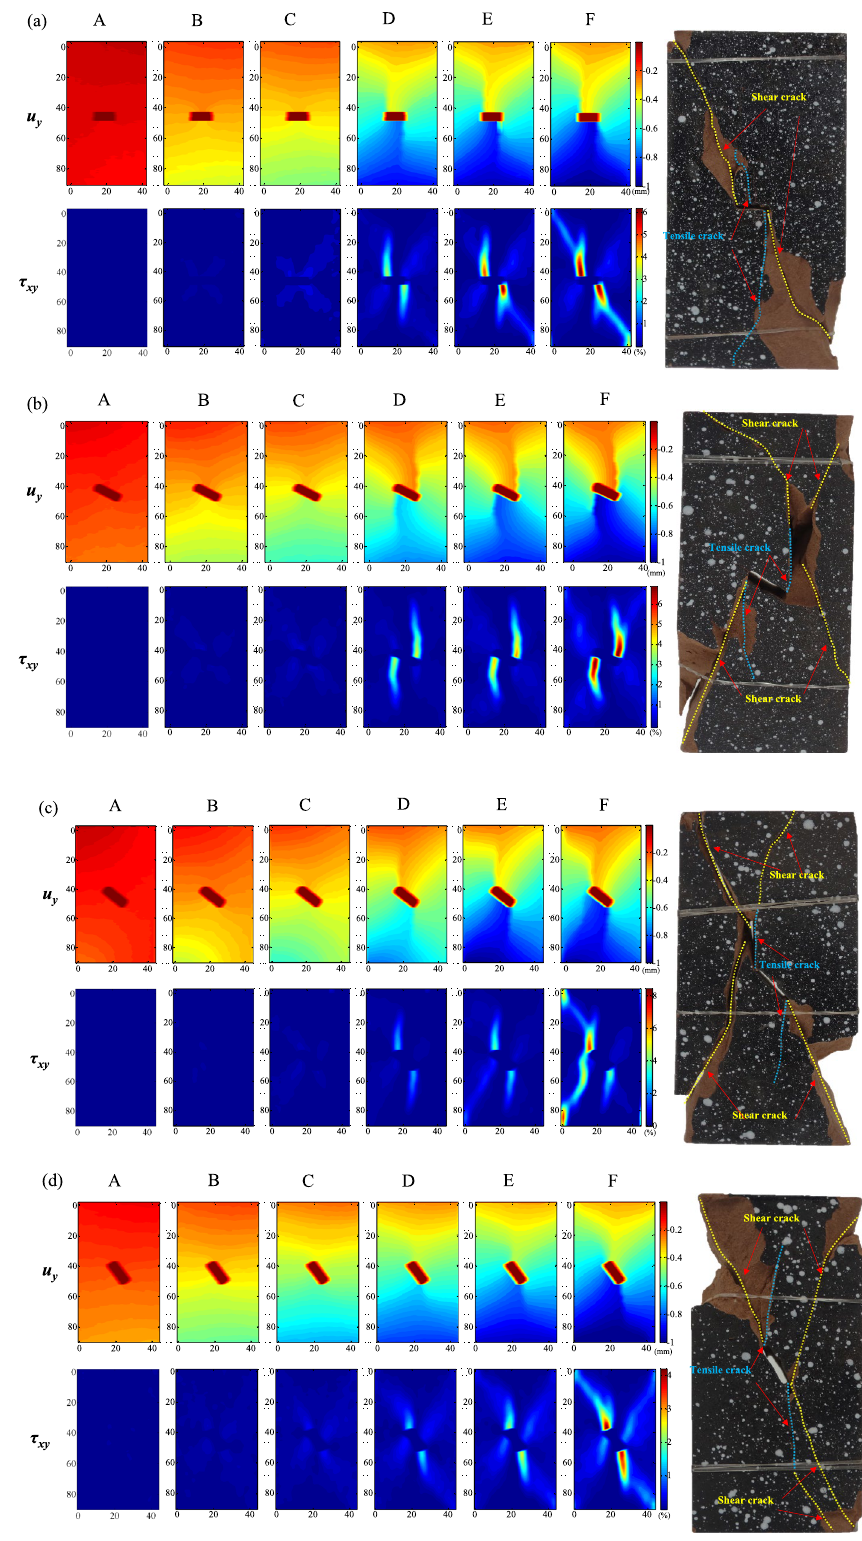
Figure 7. u y and τ xy in the surface of rock specimens: ( a ) Specimen No. 0-1, ( b ) Specimen No. 30-1, ( c ) Specimen No. 45-1, and ( d ) Specimen No.